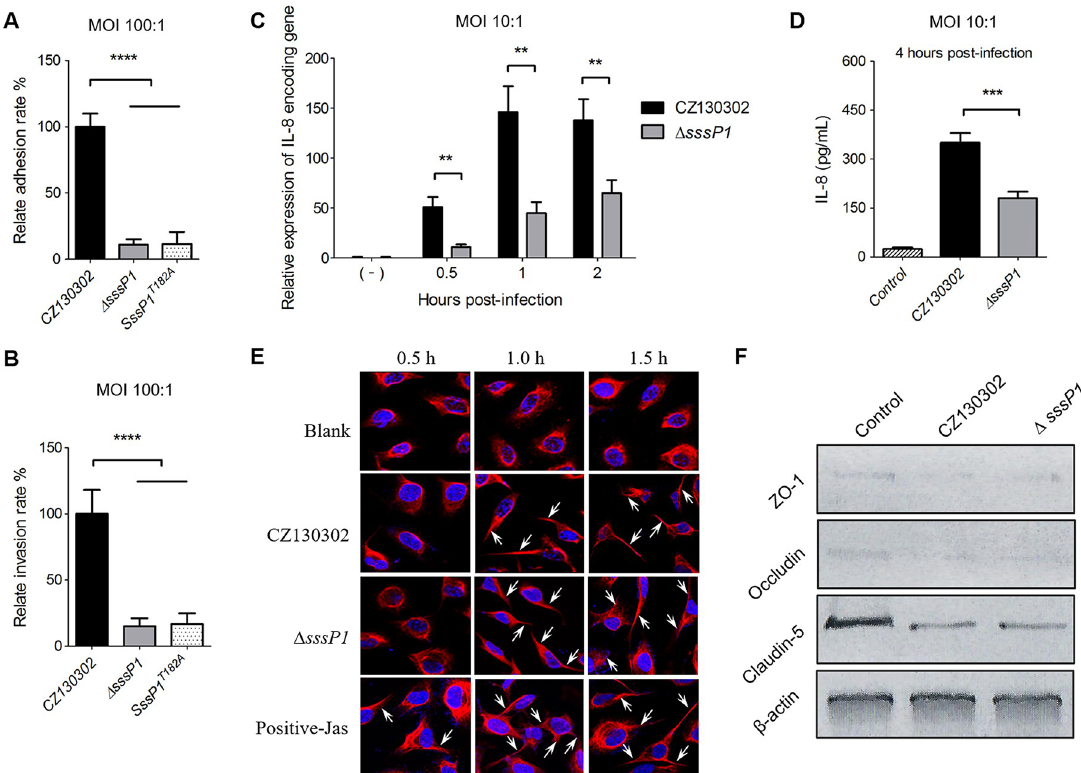
Fig 4. The sssP1 plays significant roles in adherence and invasion. All data are represented as mean ± SEM of triplicate samples ( ���� P < 0.0001, ��� P < 0.001, �� P < 0.01). (A, B) The adhesion and invasion levels of the indicated S . suis strains to HBMECs were detected at the MOI 100:1. (C) The transcriptional level of IL-8 encoding gene in the HBMECs interacted with different S . suis strains were detected using an RT-qPCR assay at the indicated times post-infection. (D) The releasing levels of IL-8 in the cultural supernatant of the HBMECs infected with different S . suis strains were measured at 4 h post-infection. (E) Cytoskeletal changes of HBMECs in response to infection by S . suis CZ130302 and Δ sssP1 . Cells were stained with phalloidin to show actin filaments and were imaged using confocal microscopy. Control HBMECs were incubated without bacteria. Otherwise, HBMECs were incubated with S . suis for 0.5, 1.0, and 1.5 h before phalloidin staining. (F) Levels of the three major components of TJs, ZO-1, occludin and claudin-5, were detected using a Western blot assay to the total protein samples from the HBMECs infected with the indicated strains. β -actin was used as a loading